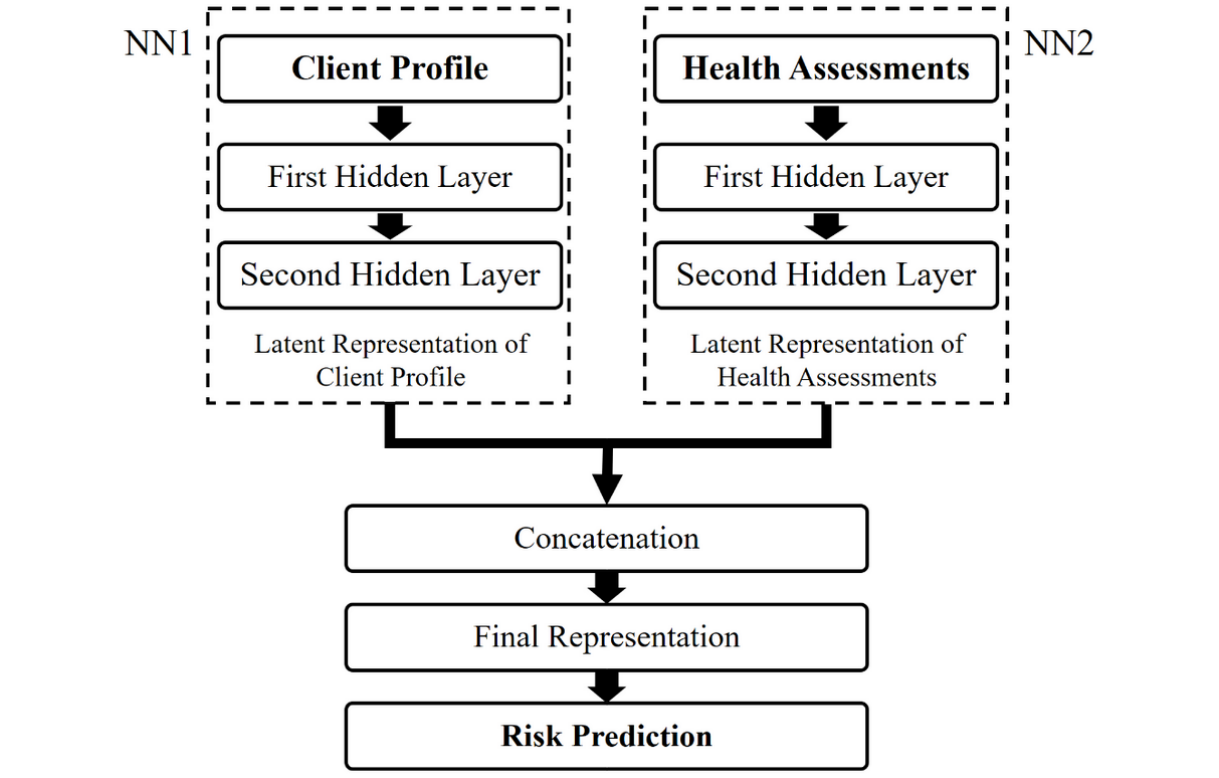
Figure 3. The architecture of the dual neural network. NN1: neural network 1; NN2: neural network